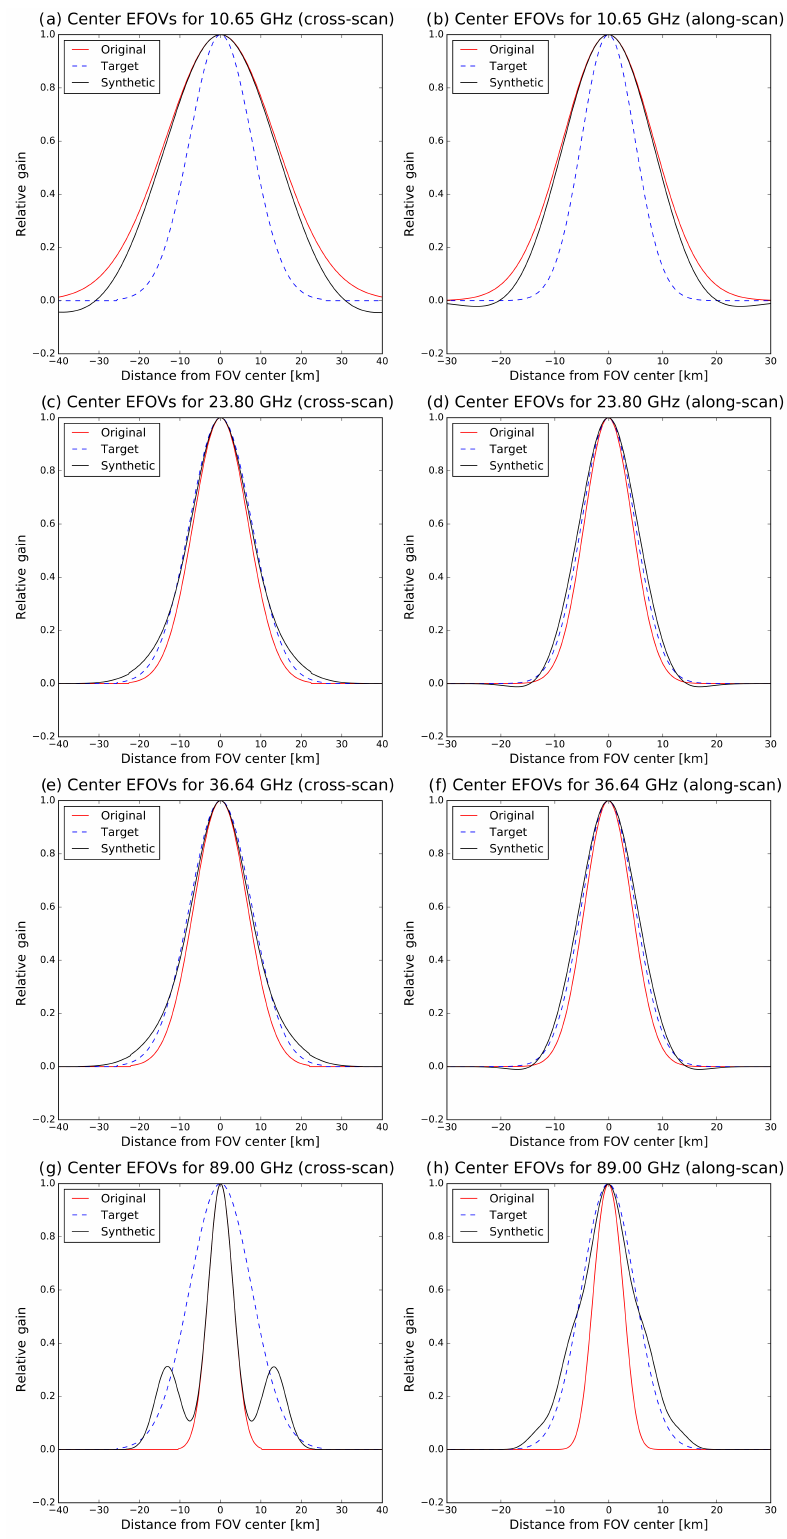
Figure 5. From top to bottom, the shape of the final synthetic EFOVs at the center of the swath for 10.65, 23.80, 36.64, and 89.0GHz (solid curves). For comparison, the native EFOVs (red curve) and target 18.70GHz EFOVs (blue dashed curve) are shown. The left column is for the cross-scan direction; the right column is for the along-scan